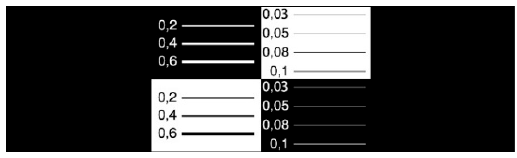
Figure 3. Test image transferred from the digital file to the printing plate .